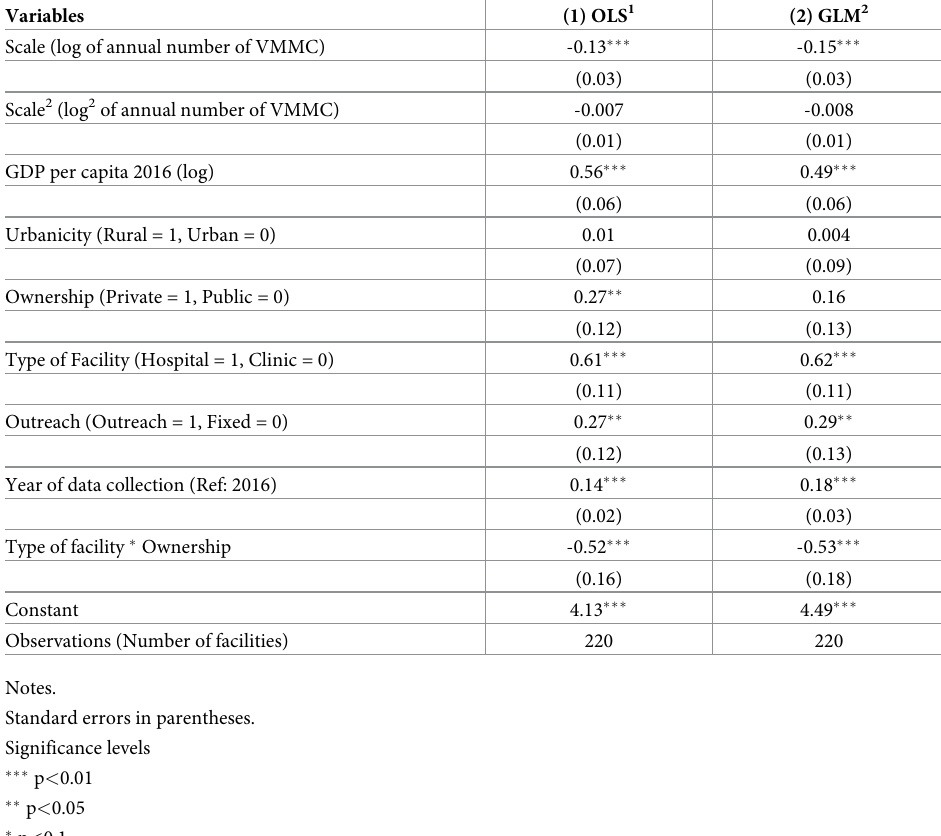
Table 2. Regression models on the determinants of VMMC unit cost variations. The Dependent Variable is the Logarithm of the Facility-Level VMMC Unit Cost.